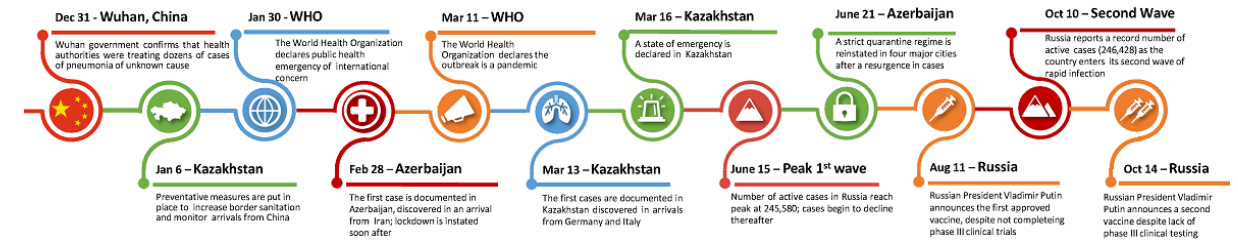
Figure 1. Timeline of the COVID-19 pandemic in Central